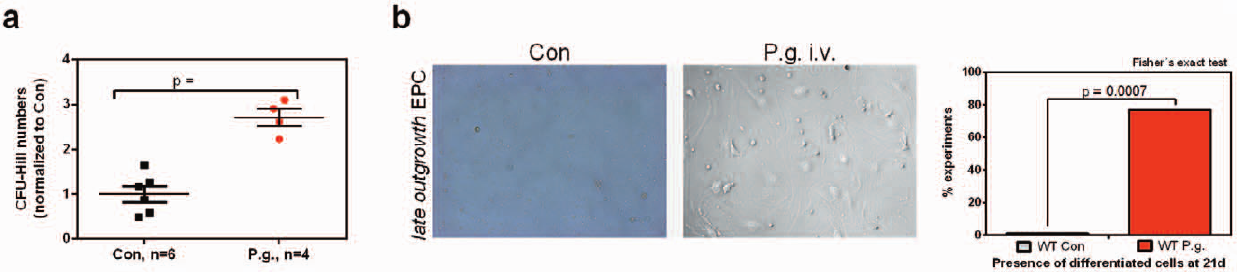
Figure 3. Bacteremia with P. gingivalis leads to increased numbers of CFU-Hill and late-outgrowth EPC in wildtype mice. (a) Increased numbers of CFU-Hill, (b) high proportion of presence of differentiated late-outgrowth EPC in P. gingivalis infected mice. Data are presented as mean colony counts 6 SEM relative to controls (CFU-Hill) or as numbers of experiments yielding differentiated colonies (late EPC). Data were analyzed using unpaired t-tests (CFU-Hill) or Fishers exact test (late EPC).